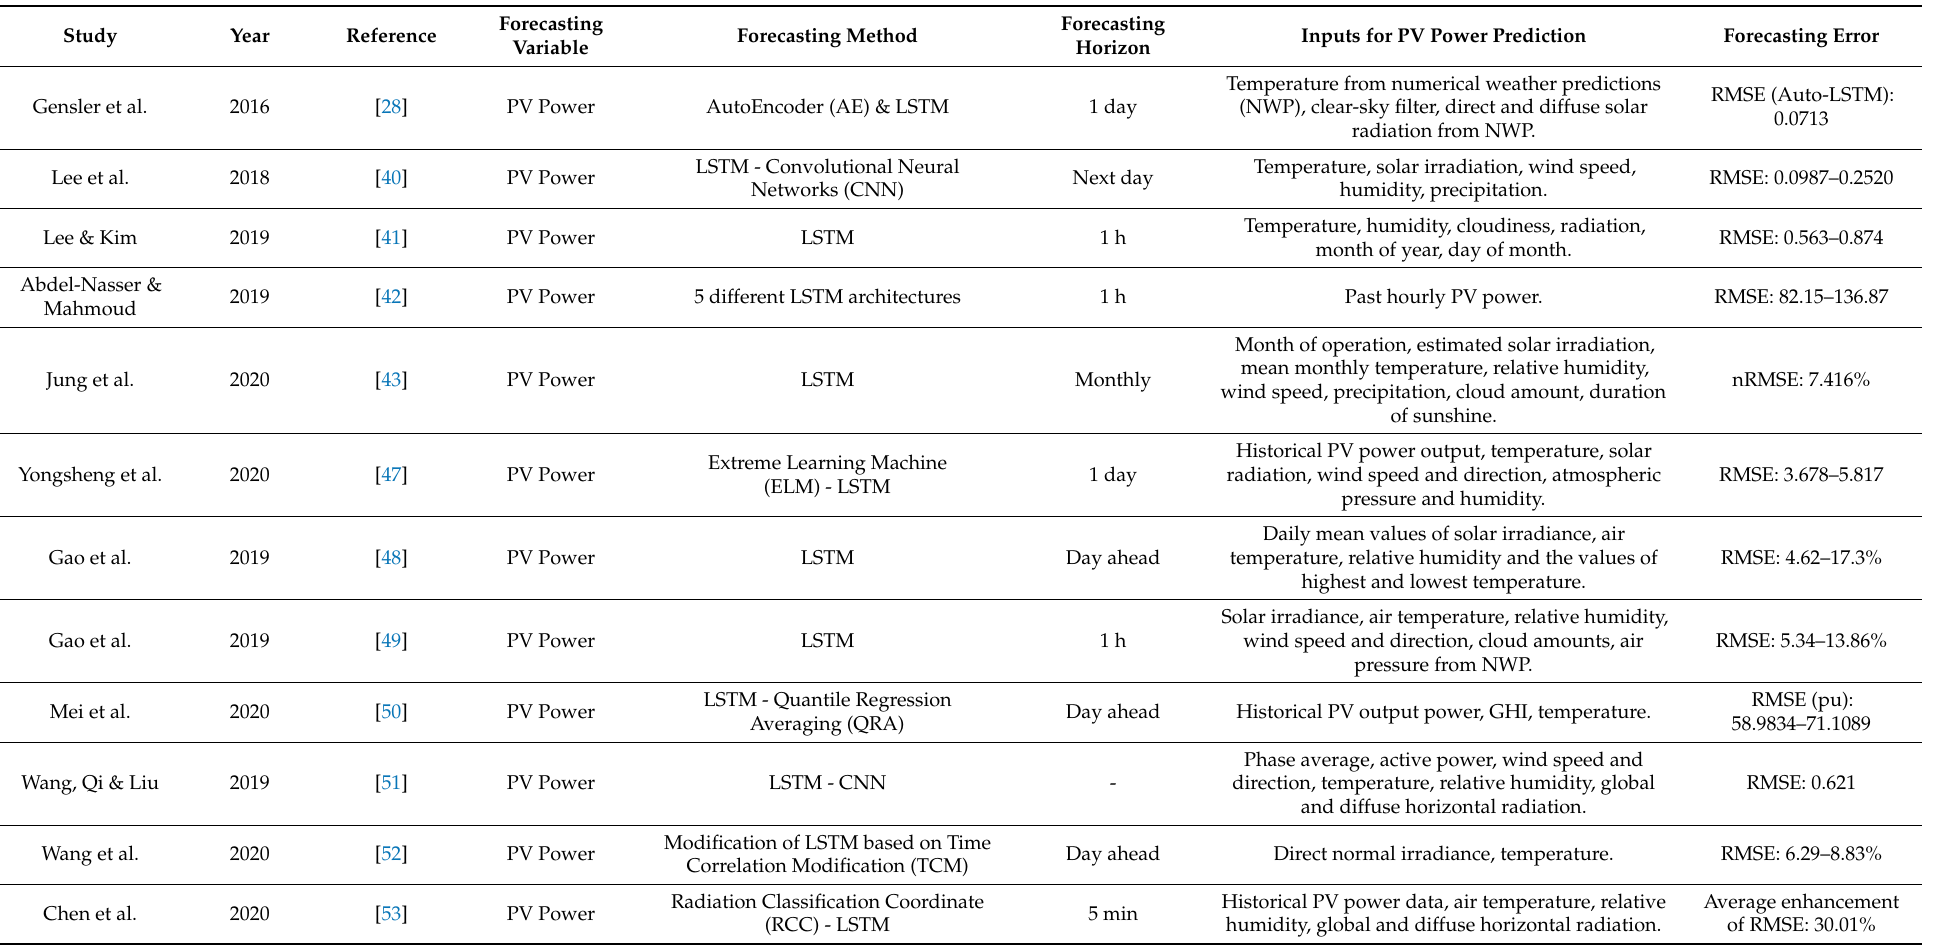
Table 1. A summary of previous studies on photovoltaic (PV) power output prediction using Long Short-Term Memory (LSTM)